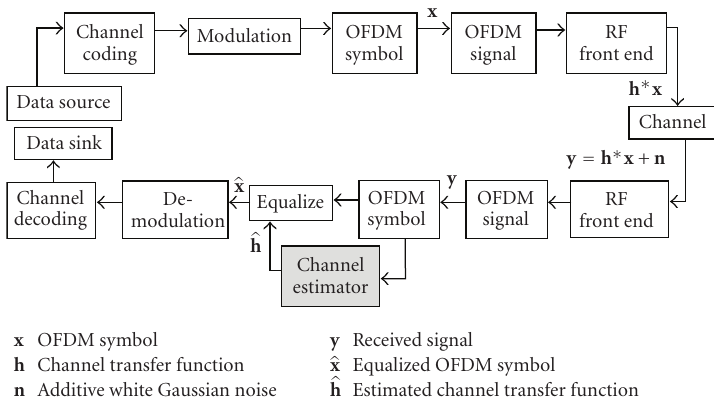
Figure 1: An overview of OFDM system.